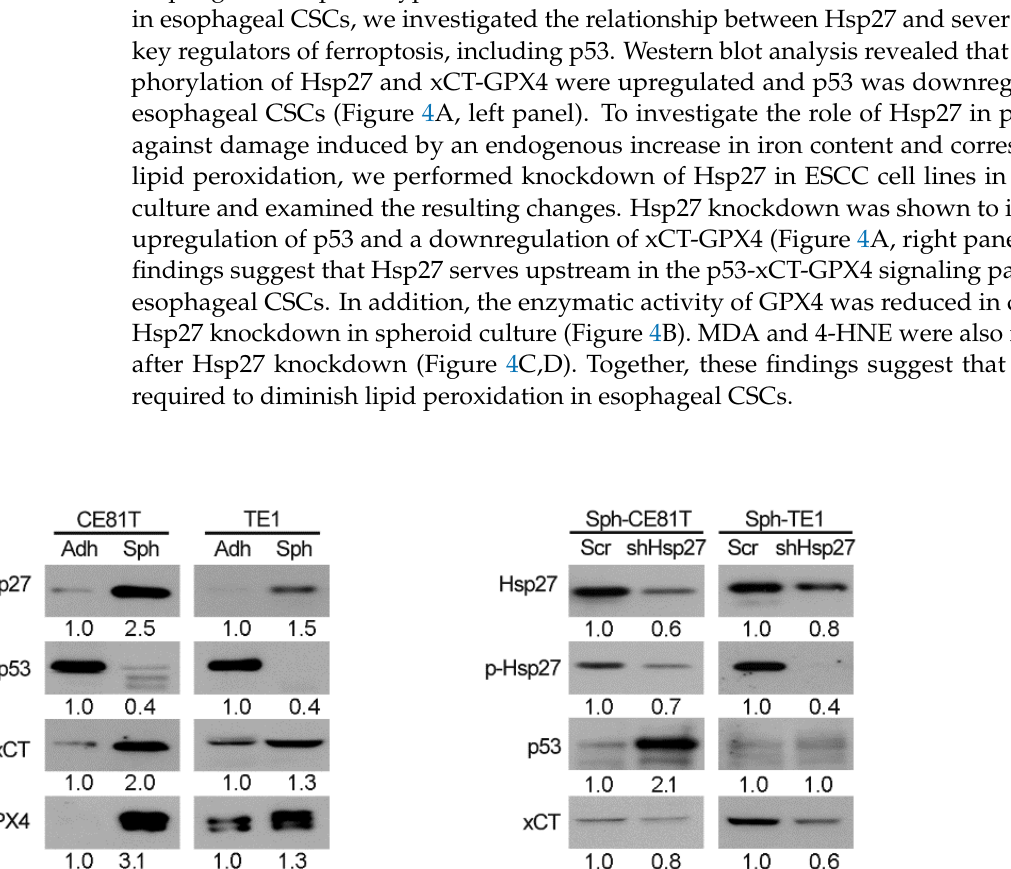
Figure 4. Knockdown of Hsp27 in esophageal cancer cells in spheroid culture induced more lipid peroxidation. ( A ) Left panel, Western blot analysis with quantification of Hsp27, phospho-Hsp27, p53, xCT, and GPX4 of CE81T and TE1 cells in spheroid and adherent culture. Right panel, Western blot analysis with quantification of Hsp27, phospho-Hsp27, p53, xCT, and GPX4 of CE81T and TE1 cells with Hsp27 knockdown (shHsp27) in spheroid culture. Scr, scramble. ( B ) Glutathione meas- urement of TE1 and CE81T cells with Hsp27 knockdown in spheroid culture. ( C ) MDA production of TE1 and CE81T cells with Hsp27 knockdown in spheroid culture. ( D ) 4-HNE of TE1 and CE81T cells with Hsp27 knockdown in spheroid culture. * p < 0.05, ** p < 0.01, *** p < 0.001. p value of B was calculated by two-way ANOVA. p value of C and D were calculated by Student’s t -test. 3.5. Expression of Phospho-Hsp27/GPX4 Is Predictive of Poor Prognosis in Cases of Esophageal Cancer To investigate the clinical significance of Hsp27and GPX4, we utilized immunohisto- chemical (IHC) staining to examine the expression of Hsp27 and GPX4 in the tumorous specimens of patients who underwent surgical resection for esophageal cancer in our hos- pital. The clinical demographics of these patients are listed in Supplementary Table S1. Kaplan–Meier analysis revealed that patients who displayed positive staining of either phospho-Hsp27 or GPX4 (Figure 5A) in their tumors exhibited poorer survival compared with patients who were negative for these markers (Figure 5B). The survival difference in the double-positive versus double-negative expression of phospho-Hsp27 and GPX4 was more obvious than that in single-positive versus single-negative groups (Figure 5B). These